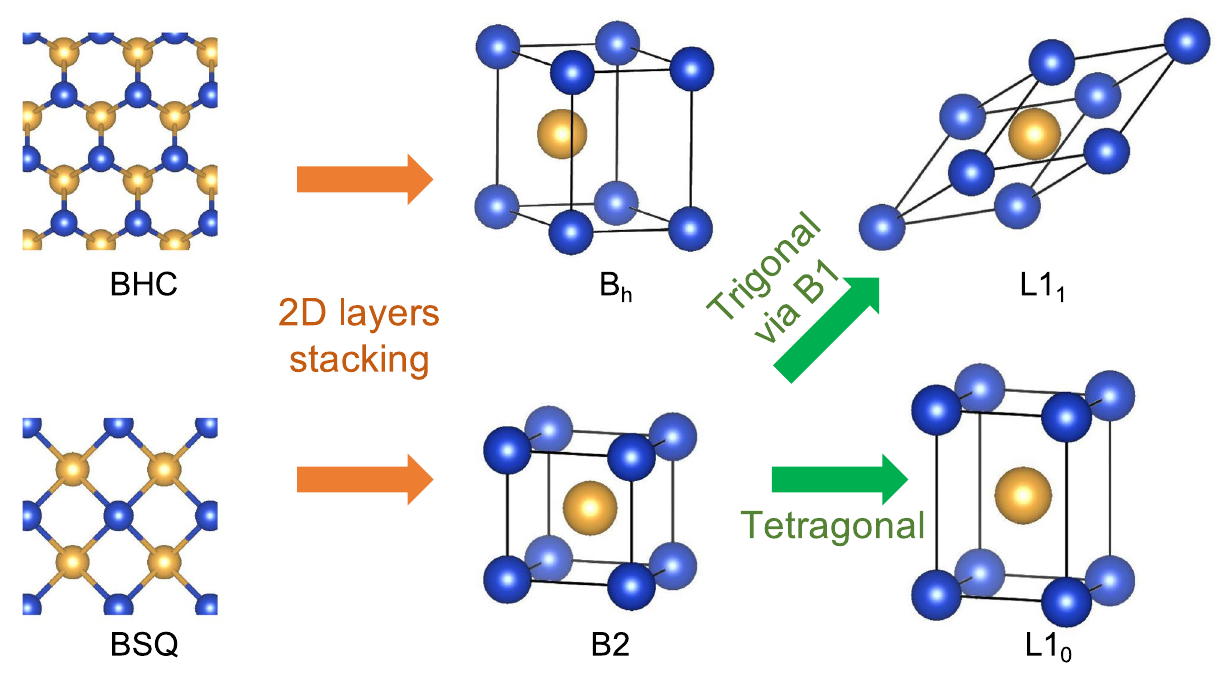
Figure 1. Illustrations of the 2D (BHC and BSQ) and 3D structures (B h , L1 1 , B2, and L1 0 ) and its interrelationships: Stacking the 2D structures vertically produces the 3D structures and the tetragonal and trigonal distortions of the B2 structure yield the L1 0 and L1 1 structures,